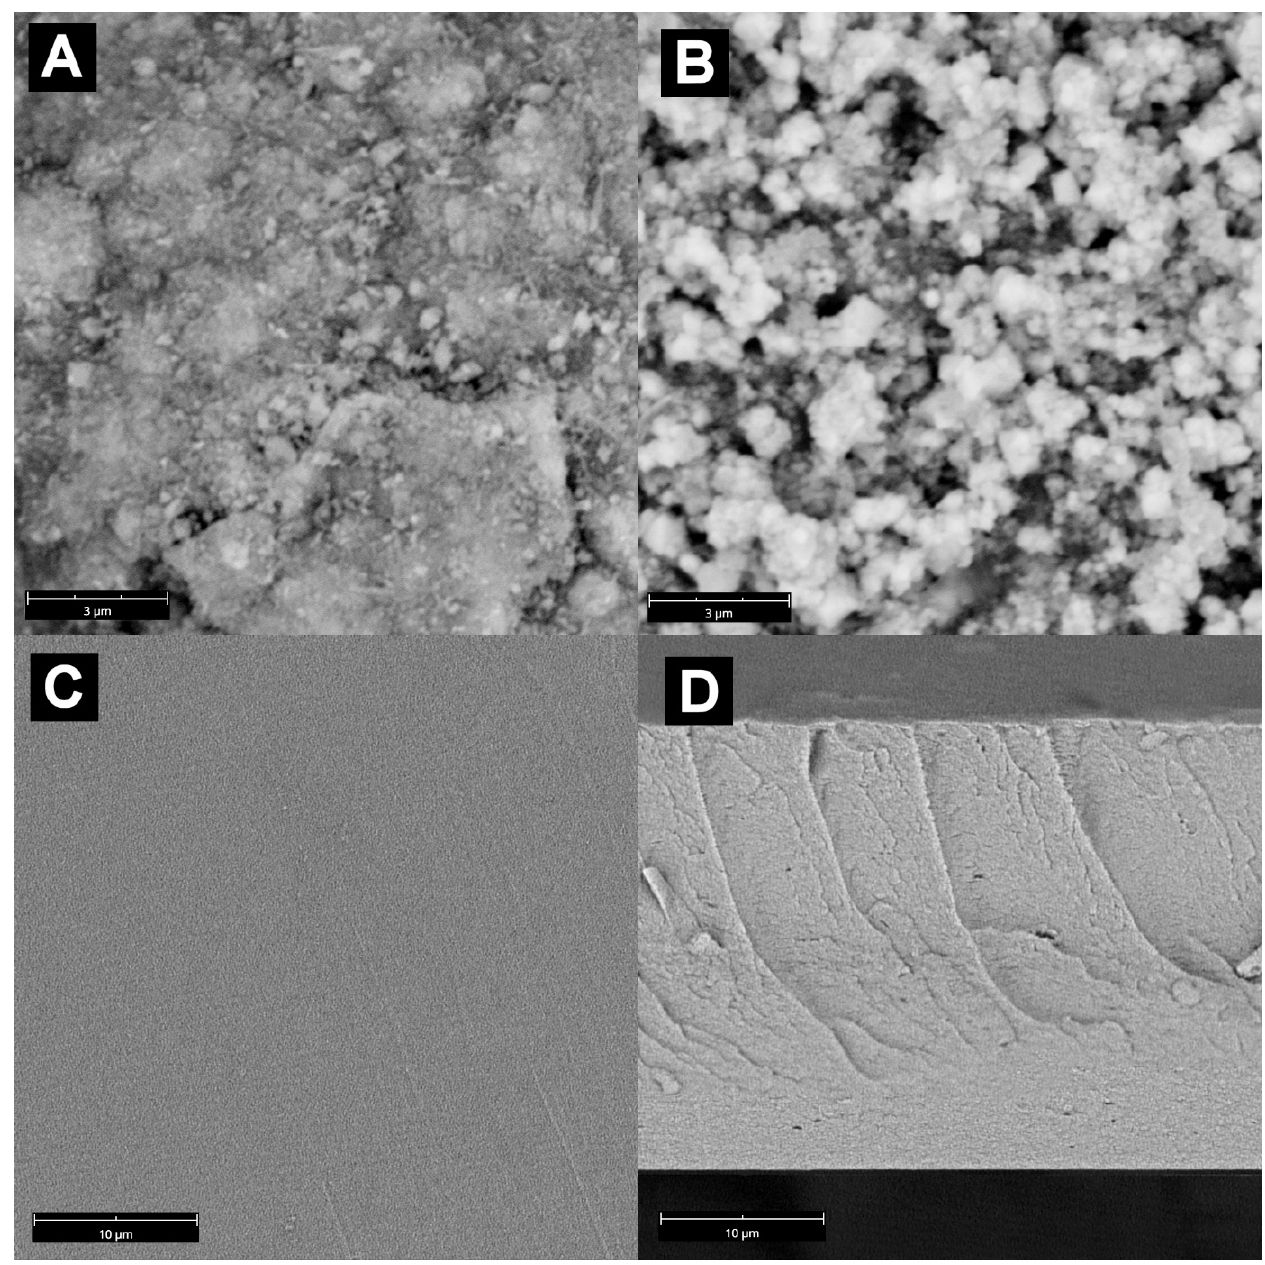
Figure 1. The SEM images of synthesized fillers. ( A )—MnO 2 . ( B )—mixed MnO 2 @Fe 3 O 4 at 20 k magnification and pristine alginate membrane: ( C )—surface; ( D )—cross-section at 7 k magnification.